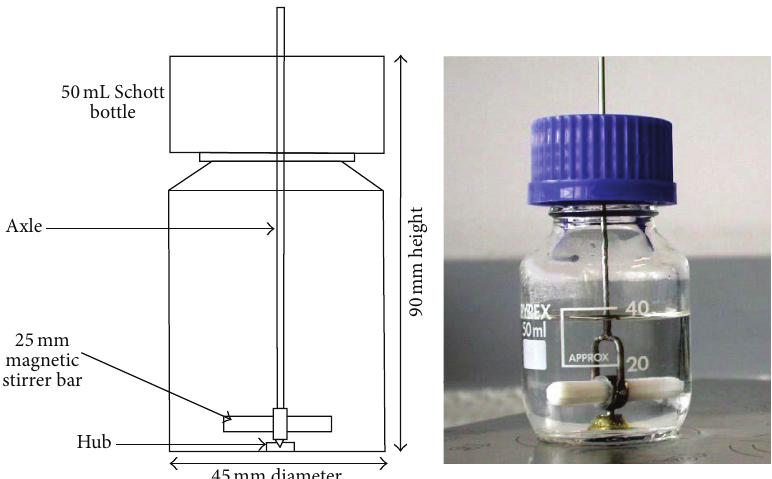
Figure 1: Stirred bottles for metastability